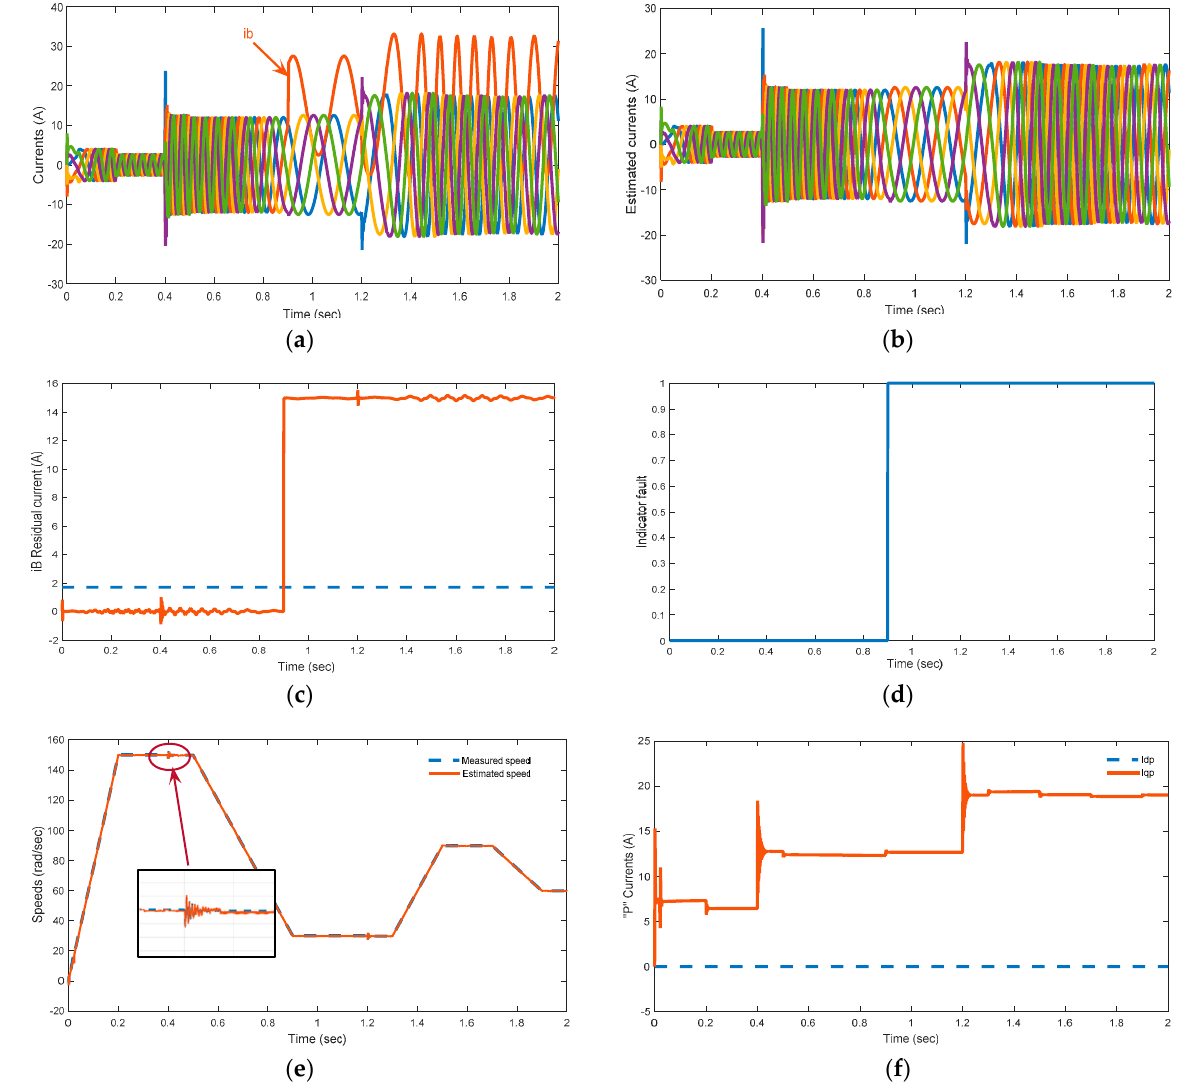
Figure 6. 5P-PMSM performance with constant fault applied in phase “b”: ( a ) stator currents with b-phase fault application; ( b ) estimated stator currents; ( c ) residual of b-phase current; ( d ) fault indicator; ( e ) measured and estimated speeds; ( f ) measured ( d p , q p ) currents responses.